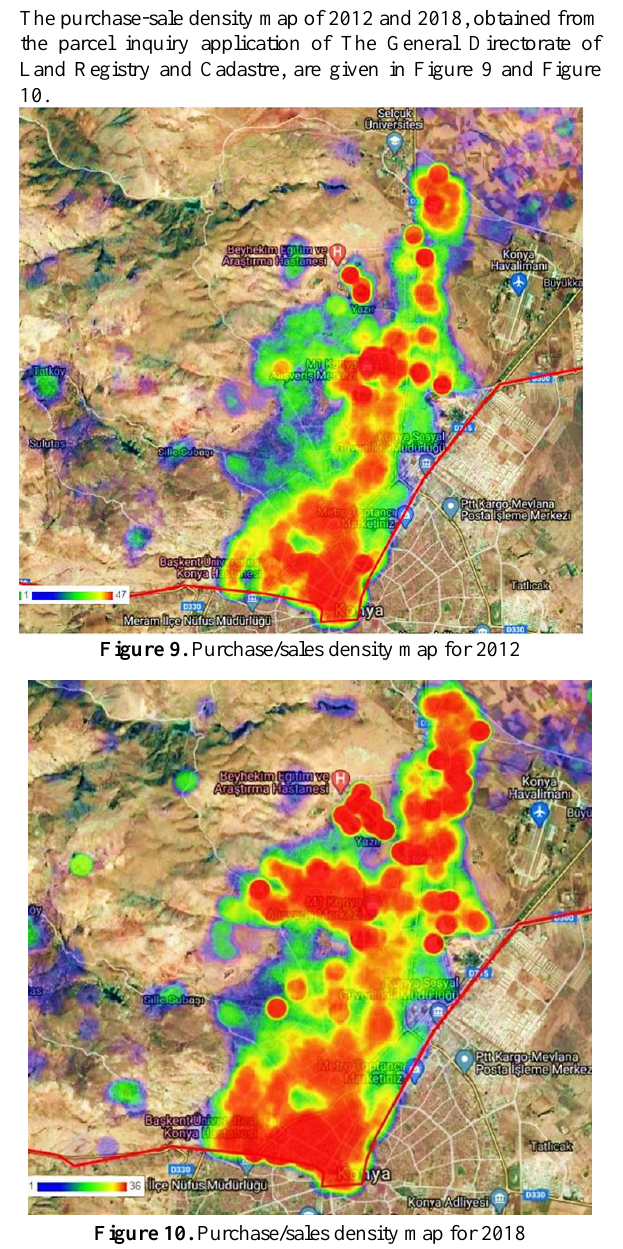
Figure 10. Purchase/sales density map for 2018